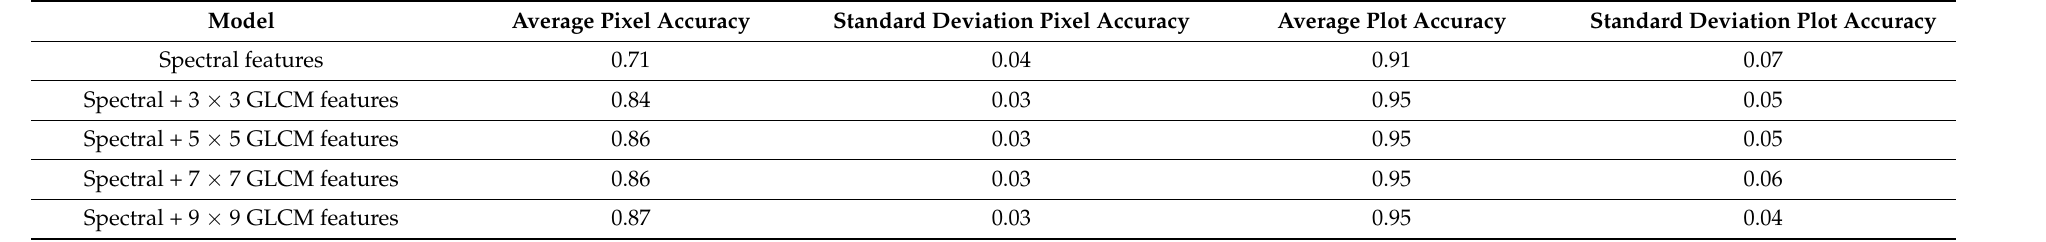
Table 2. Average accuracy of each model in pixel-based classification and plot-based classification through an 8-folds cross validation.